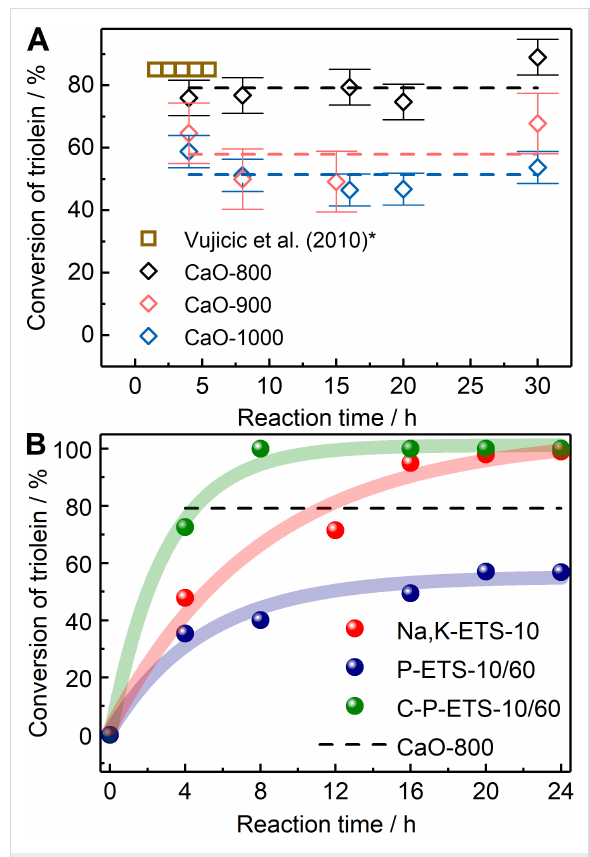
Figure 18: Conversion of triolein over CaO- (A) and ETS-10-based (B) catalysts at 403 K measured for different reaction times. The dashed lines in A represents an average conversion for each catalyst calcu- lated from the values obtained for different times assuming no time de- pendence. For comparison, the data obtained on the transesterifica- tion of sunflower oil (*recalculated for conversion of oil) at 393 K over CaO from [74] are presented. The dashed line in B was adapted from A and represents the conversion over the most active CaO catalyst (CaO-800). Semitransparent lines and conversions in B at time 0 h are used to guide the